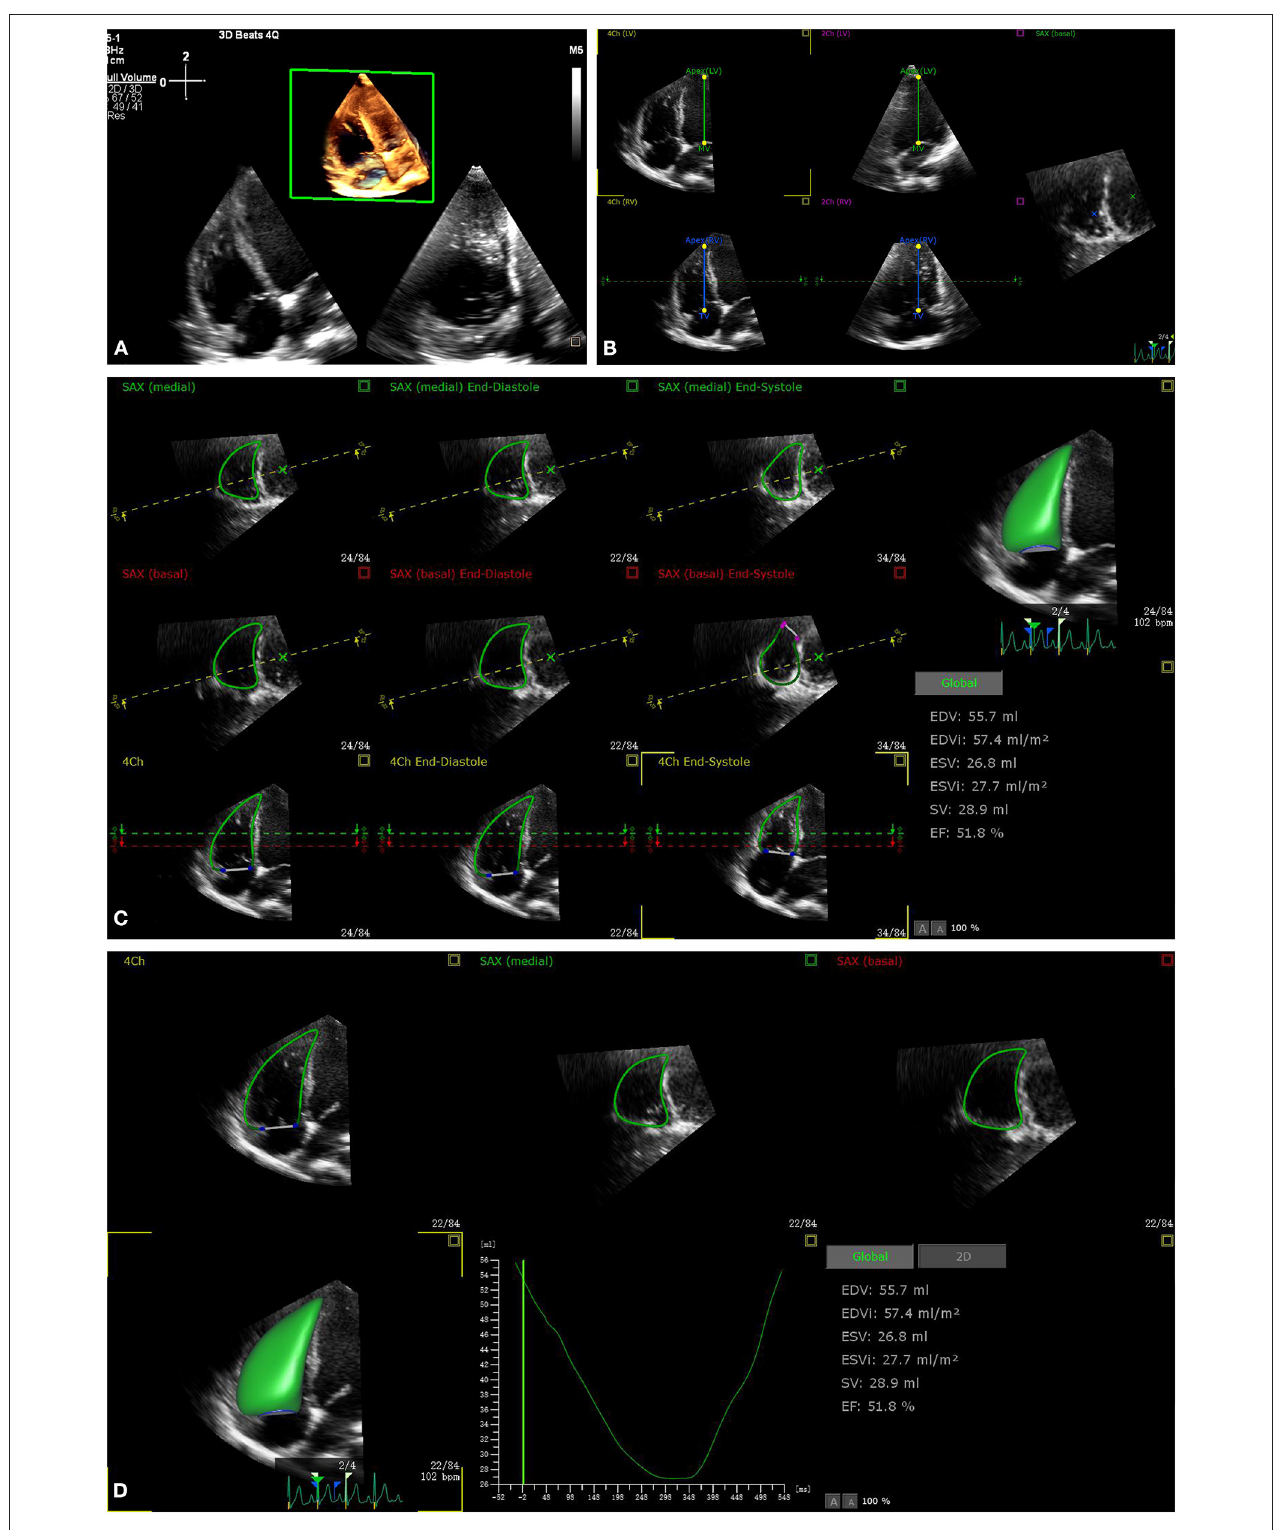
FIGURE 1 | The process of fully automated right ventricular (RV) analysis. After retrieving the RV focus three-dimensional echocardiography (3DE) data aiming for RV analysis (A) , start the software, automatically adjust the five landmarks (B) , automatically determine the RV border at end diastole and end systole (C) , and provide the results within 15 s (D)